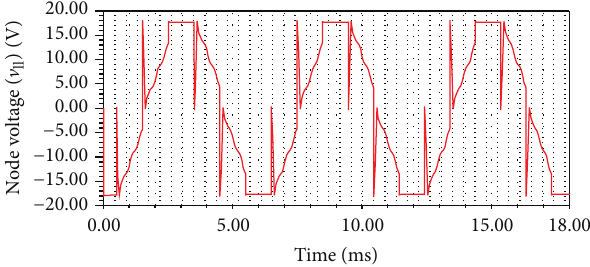
Figure 4: The line-to-line voltage waveform (without filter).